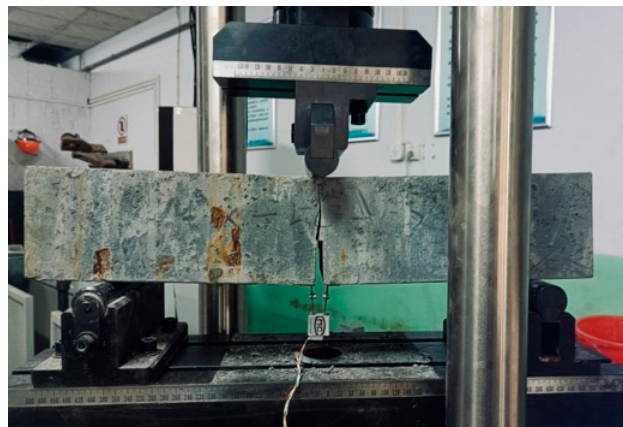
Figure 2. The three-point bending test